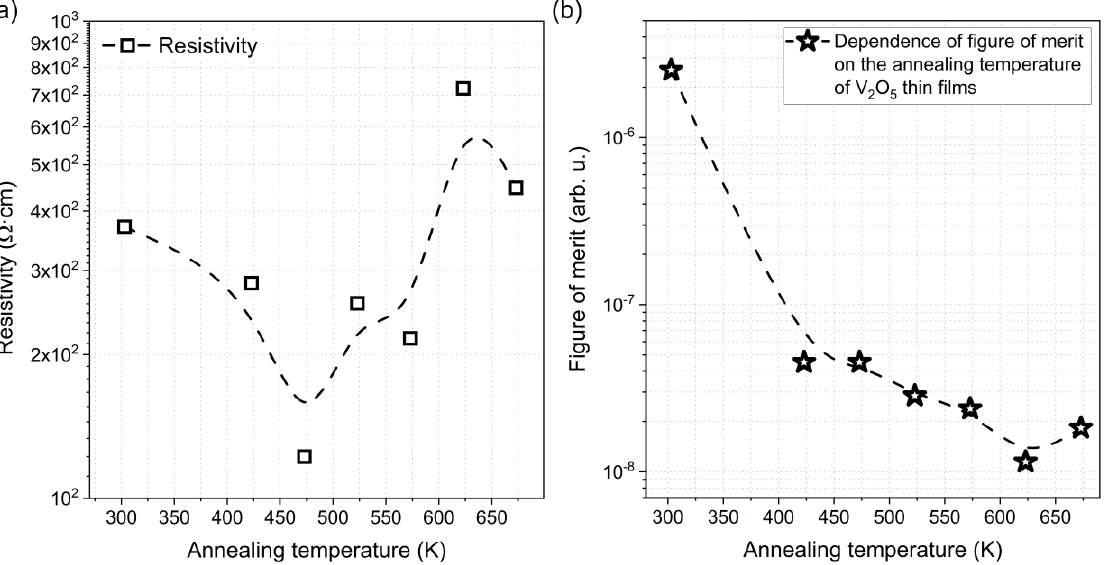
Figure 8. Dependence of: ( a ) resistivity and ( b ) figure of merit of V 2 O 5 thin films on the post-process annealing temperature.